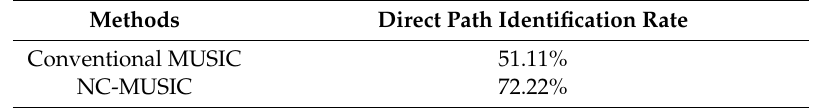
Table 8. Direct path identification rate of NC-MUSIC and conventional MUSIC in UMa scenario.